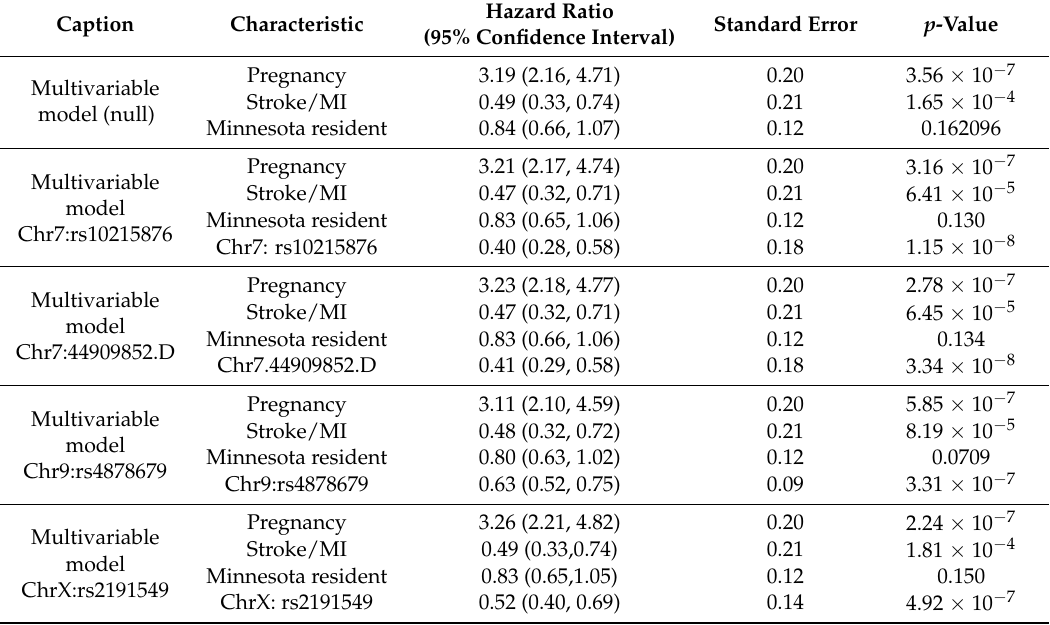
Table 3. Summary of the Cox regression model for the covariates only (null model) and including the four top single nucleotide polymorphisms (SNPs)